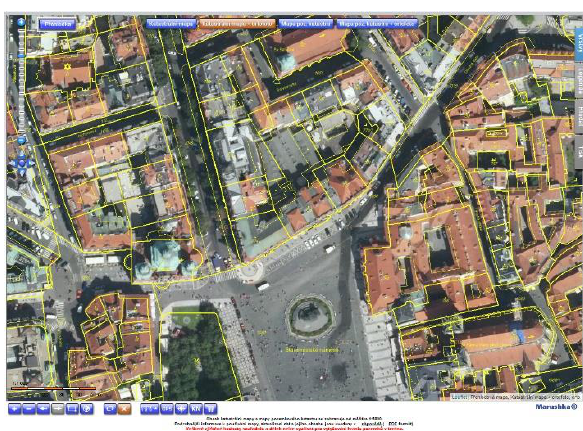
Figure 3. Web service of Registry of Territorial Identification, Addresses and Real Estate. (ČÚZK,